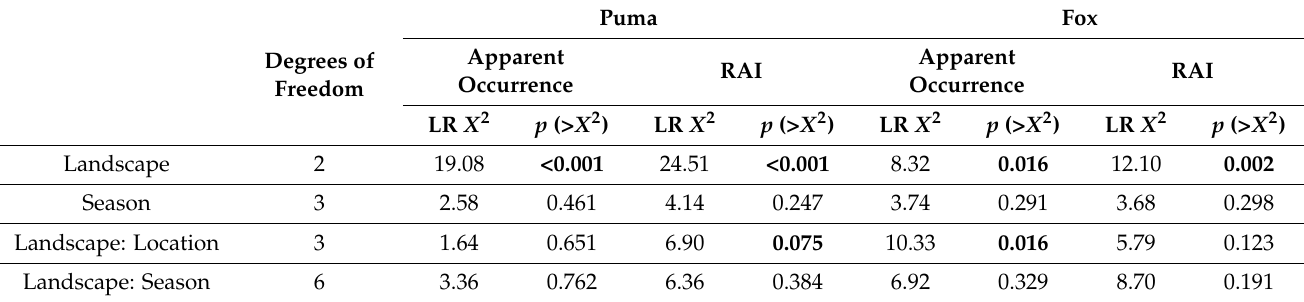
Table 3. Marginal likelihood ratio tests for the effects of landscape, season, landscape: location, and landscape: Season on the apparent occurrence and RAI of puma ( Puma concolor ) and South American grey fox ( Lycalopex griseus ) in six locations of the Southern Chile coastal range. p -values < 0.1 highlighted in